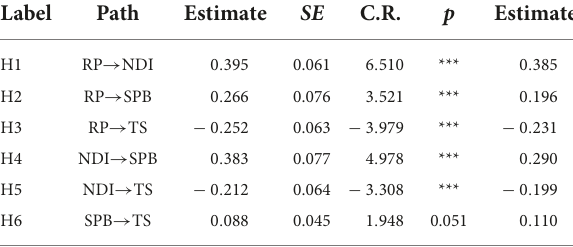
TABLE 5 Results of SEM analysis.